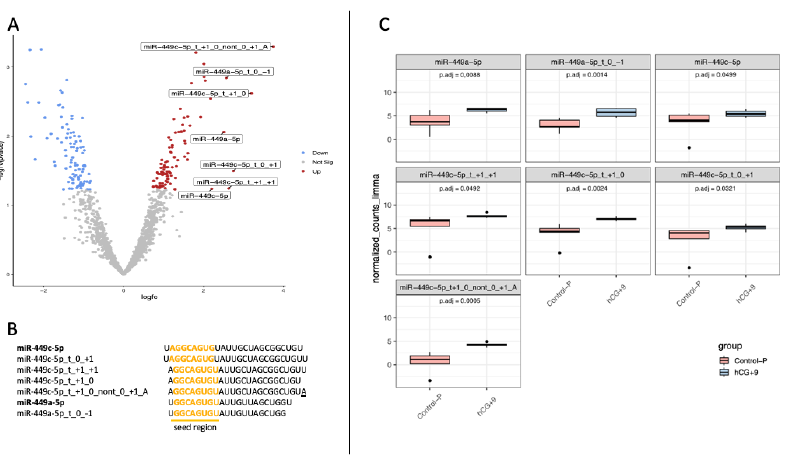
Figure 1. sRNA-seq expression data identified the miR-449 family as the most strongly up-regulated miR family in the hCG-primed receptive endometrium. ( A ) Volcano plot of DE miR and isomiRs in RE; ( B ) alignment of DE members of the family in RE with seed regions (indicated in yellow); ( C ) normalized expression of miRs and isomiRs of the family in proliferative phase (blue) and MS (hCG + 9) phase (yellow); (Limma, Galaxy Version 3.38.3). Adjusted p-values (p.adj) as generated by Limma, boxes span the 25th to 75th percentiles, whiskers extend to the 10th and 90th percentiles, and dots indicate outliers.